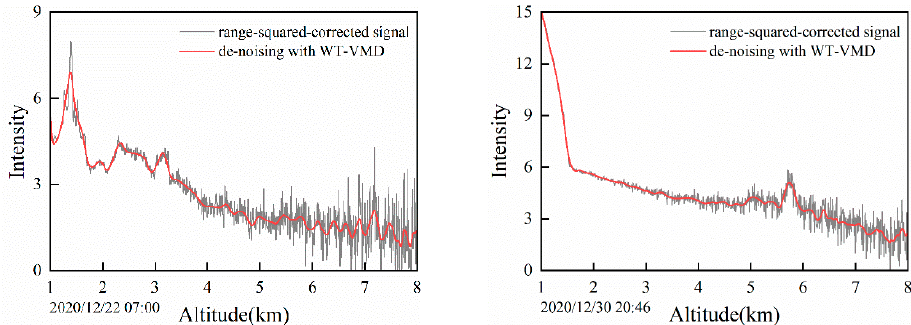
Figure 10. Comparison of denoising results for range-squared corrected signal.